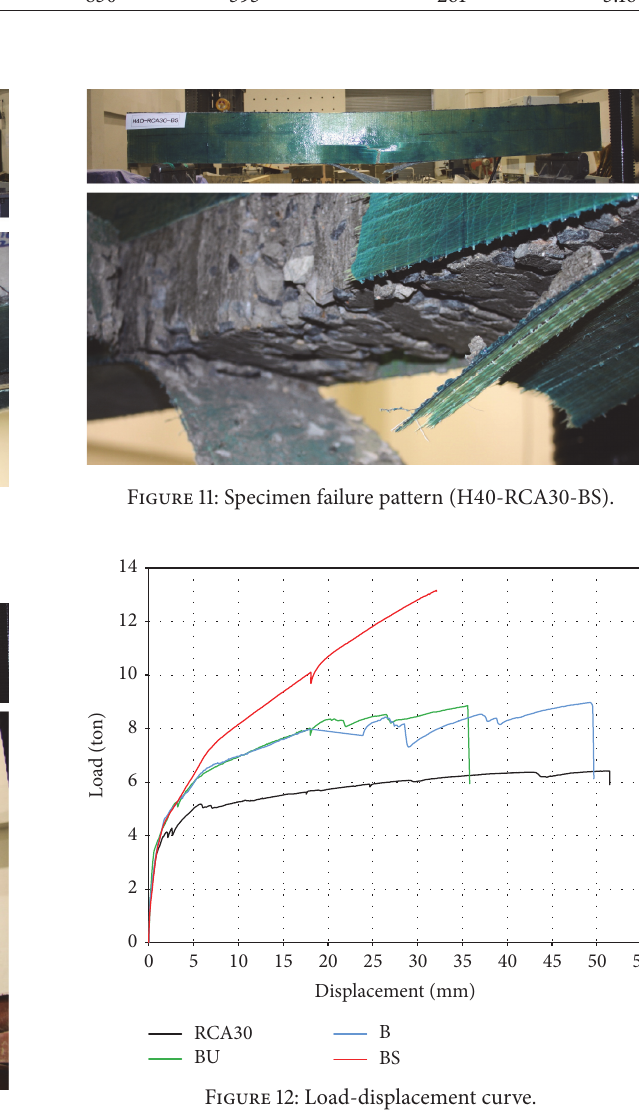
Figure 10: Specimen failure mode (H40-RCA30-BU).